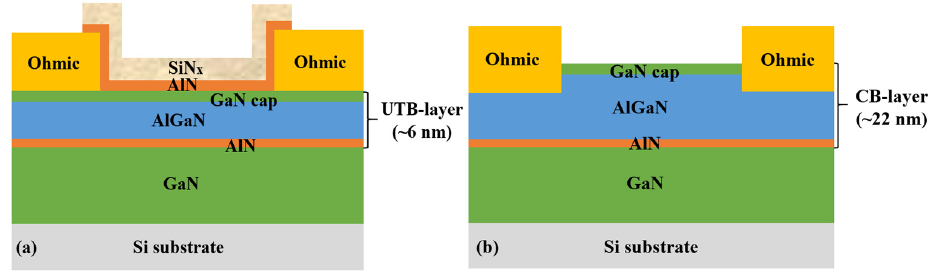
Figure 1. Schematic diagrams of the structure of the ohmic contact on ( a ) UTB − AlGaN/GaN heterostructure and ( b ) CB − AlGaN/GaN heterostructure.